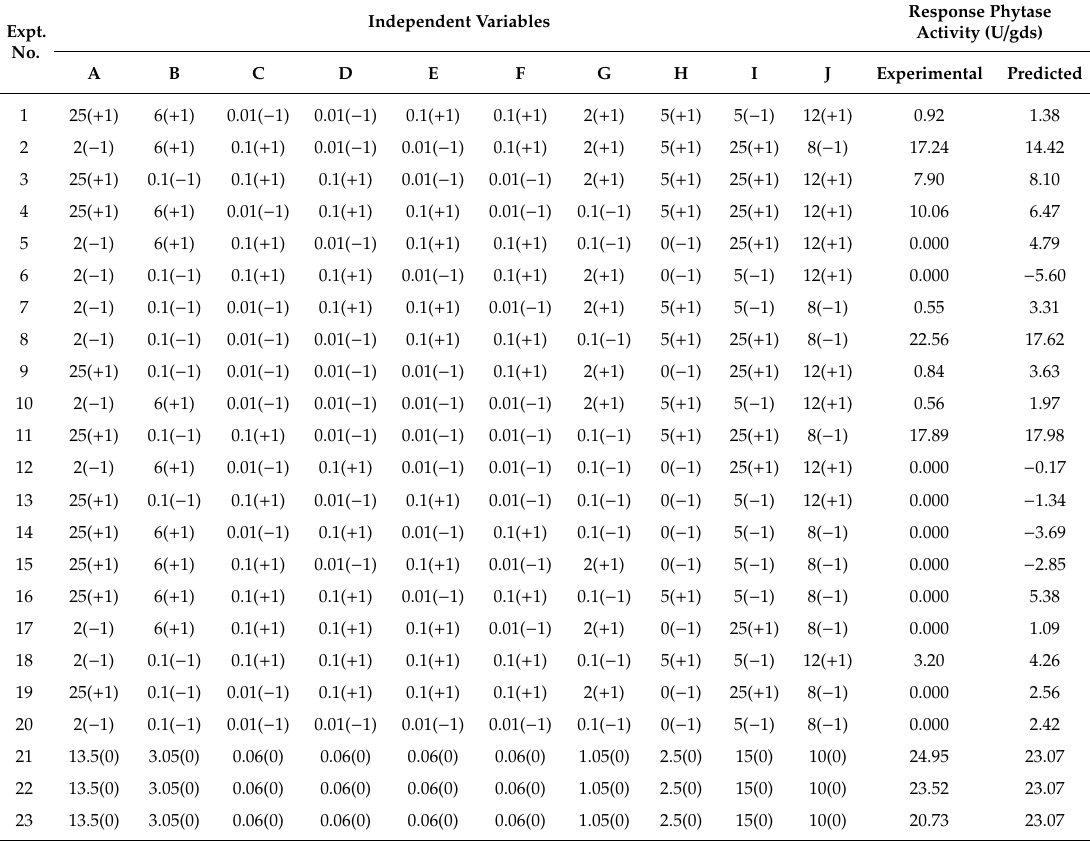
Table 1. Experimental design and respond in Plackett–Burman